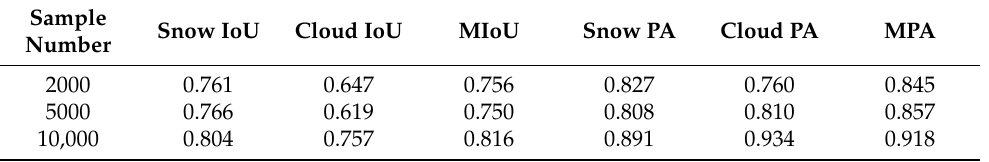
Table 3. Comparison of model test accuracy under different sample numbers.